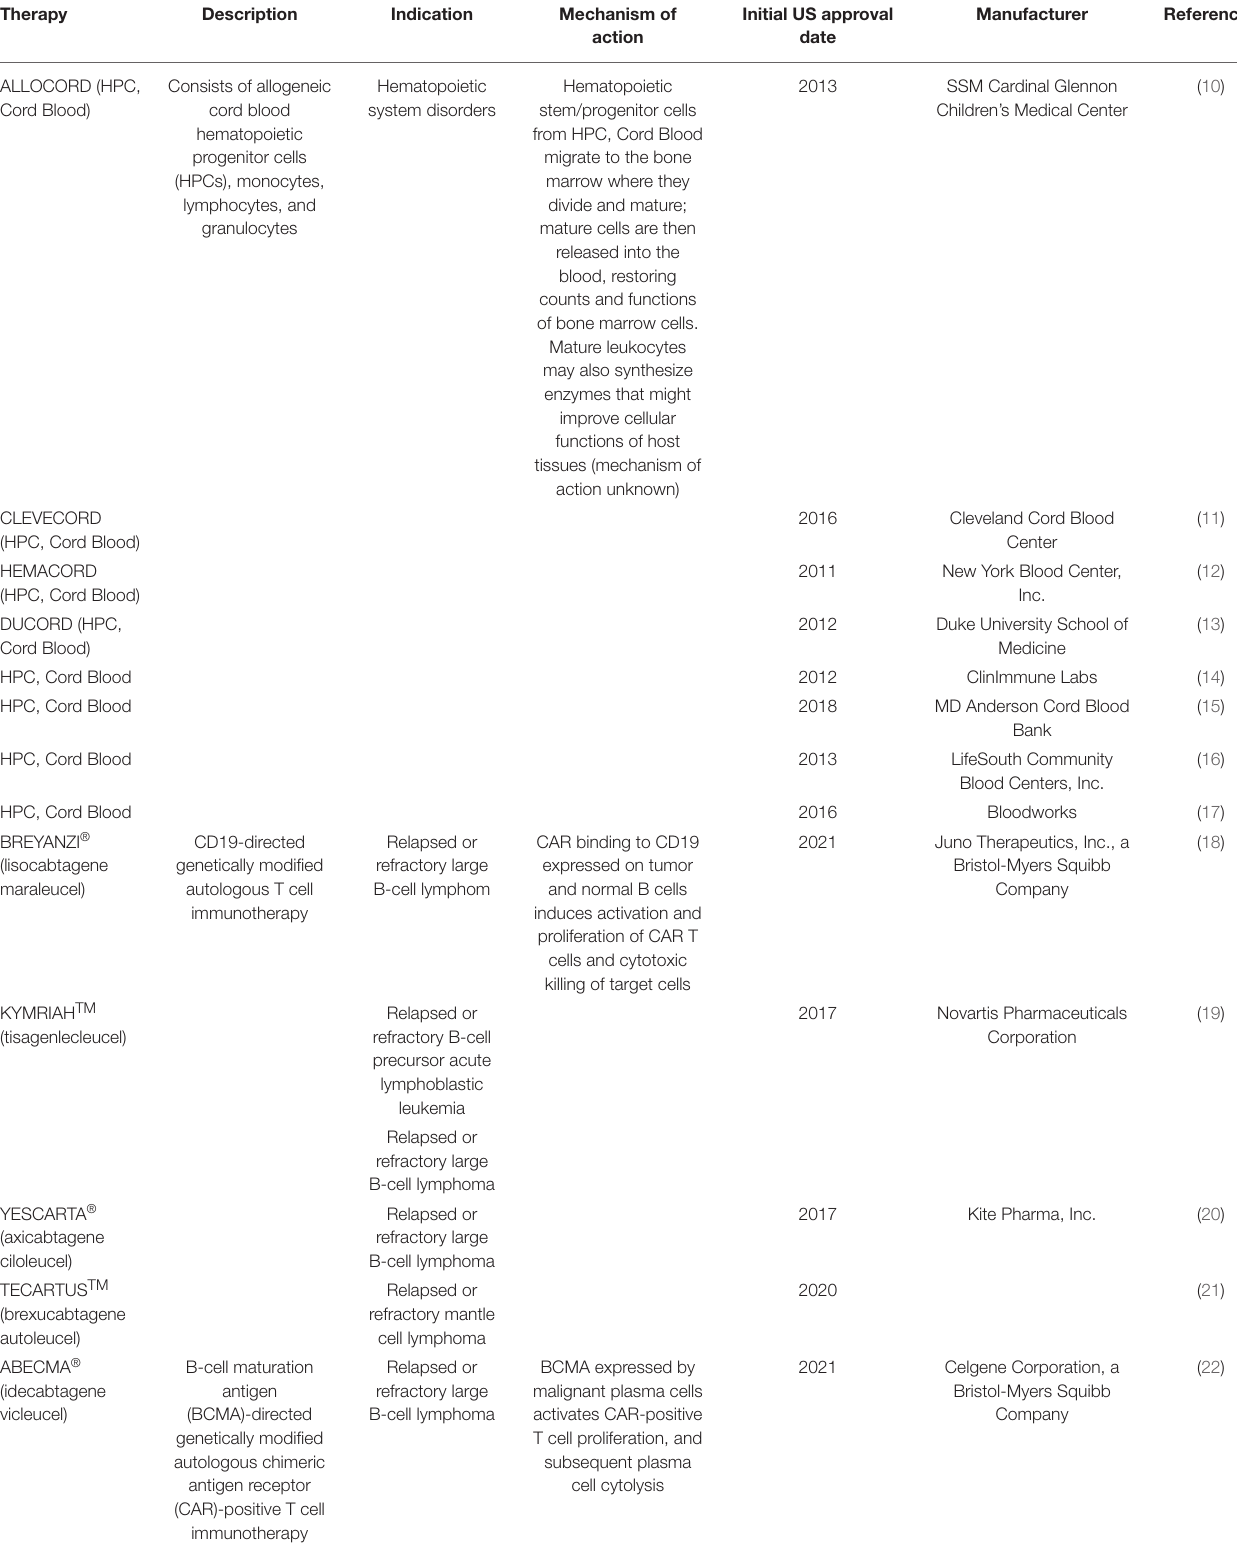
TABLE 1 | FDA-approved cell therapy products.